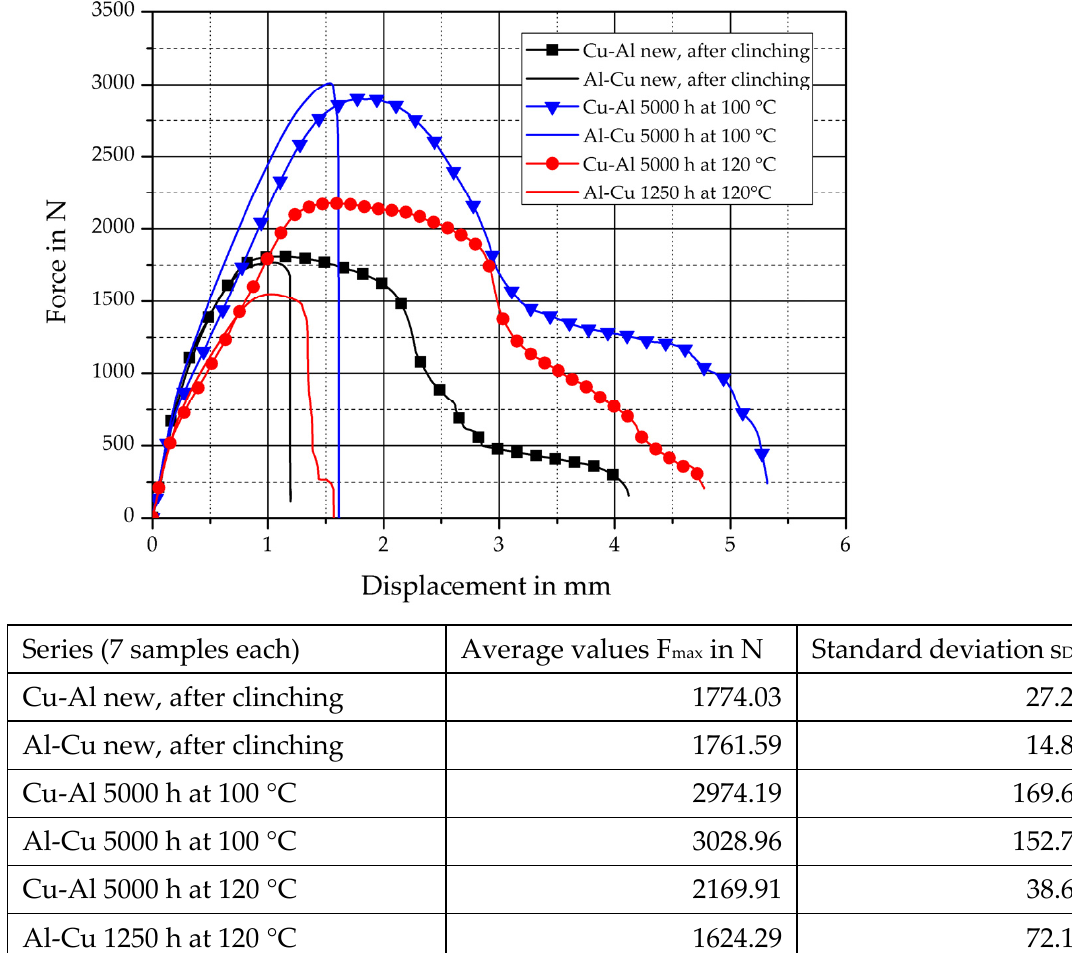
Figure 11. Quasistatic shear load—comparison of Cu-Al and Al-Cu clinch after long-term-tests. If the aluminum material is arranged on the die side, similar behavior of the test loads can be observed after the quasi-static shear tensile test. After aging at 100 ◦ C, the test load storage at 120 ◦ C, the test load drops again, but not to the level of the initial